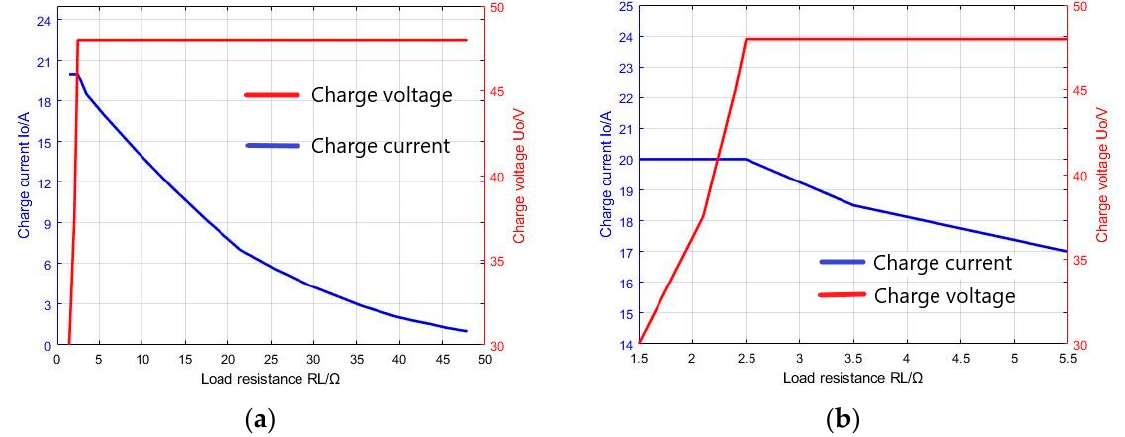
Figure 20. Charging voltage and current versus load resistance. ( a ) Change the load resistance from 1.5 Ω to 48 Ω . ( b ) Change the load resistance from 1.5 Ω to 5.5 Ω .